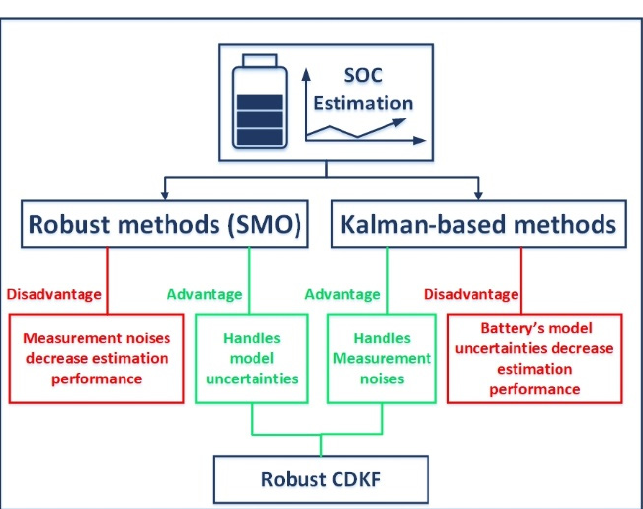
Figure 1. The motivation and advantages of the proposed method.